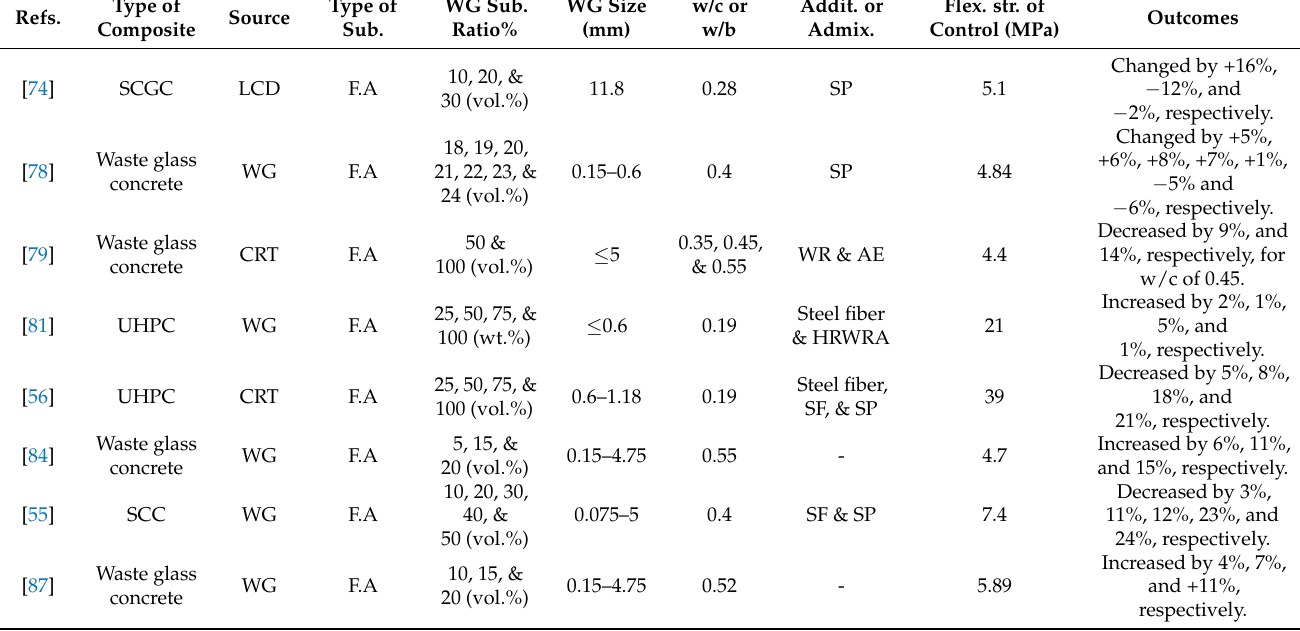
Table 8. Summary of the results of past studies on the flexural strength of waste-glass